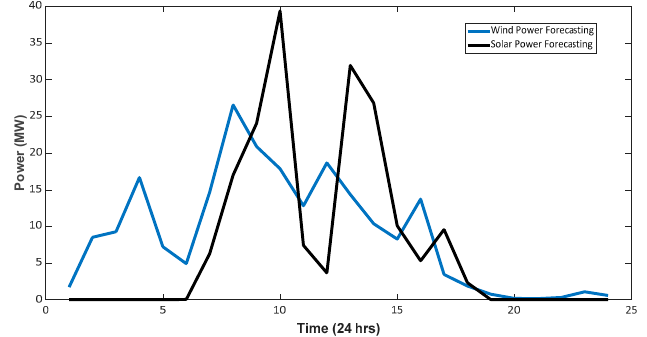
Figure 1. Wind and solar power forecasting.